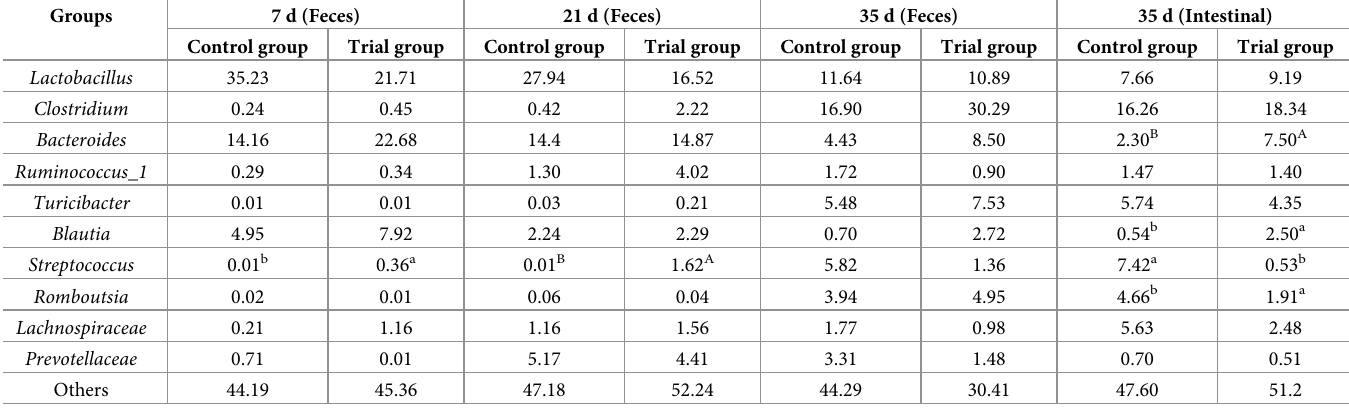
Table 6. Effect of feeding HXBM408 on the abundance of bacterium in rat feces and intestinal digesta by genus (%, n = 10).